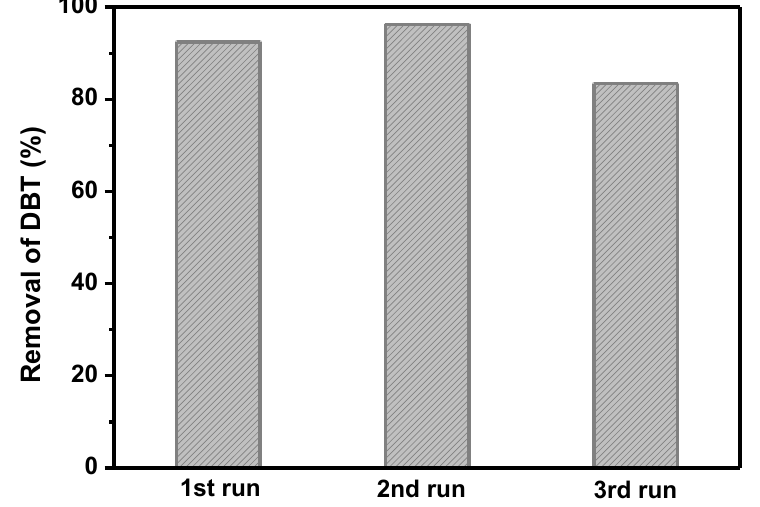
Figure 8. Recyclability of 50% Ti-MIL-101-550.